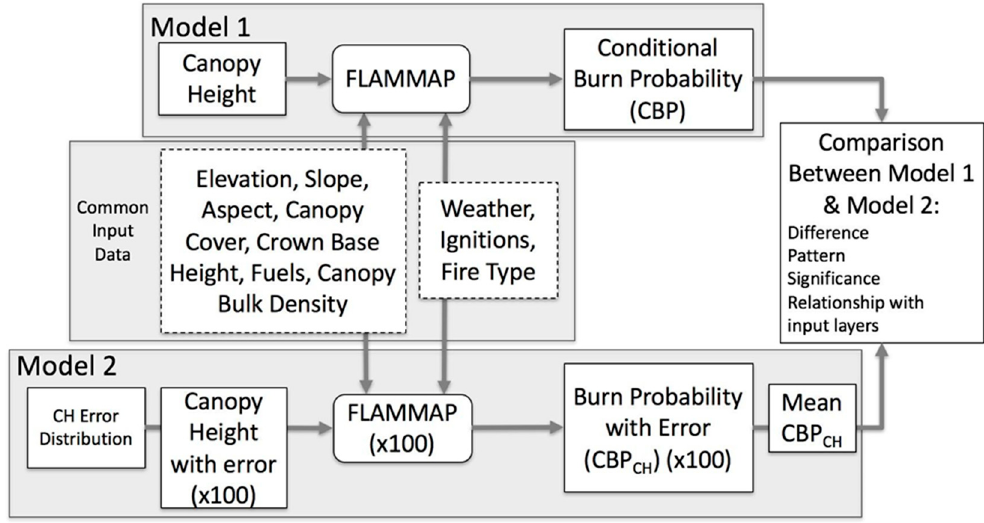
Figure 2. General workflow for creating original Model 1 run with original data, and Model 2 run (Monte Carlo with Canopy Height + Error). The same workflow holds for Model Scenario 3 (Crown Base Height + Error).